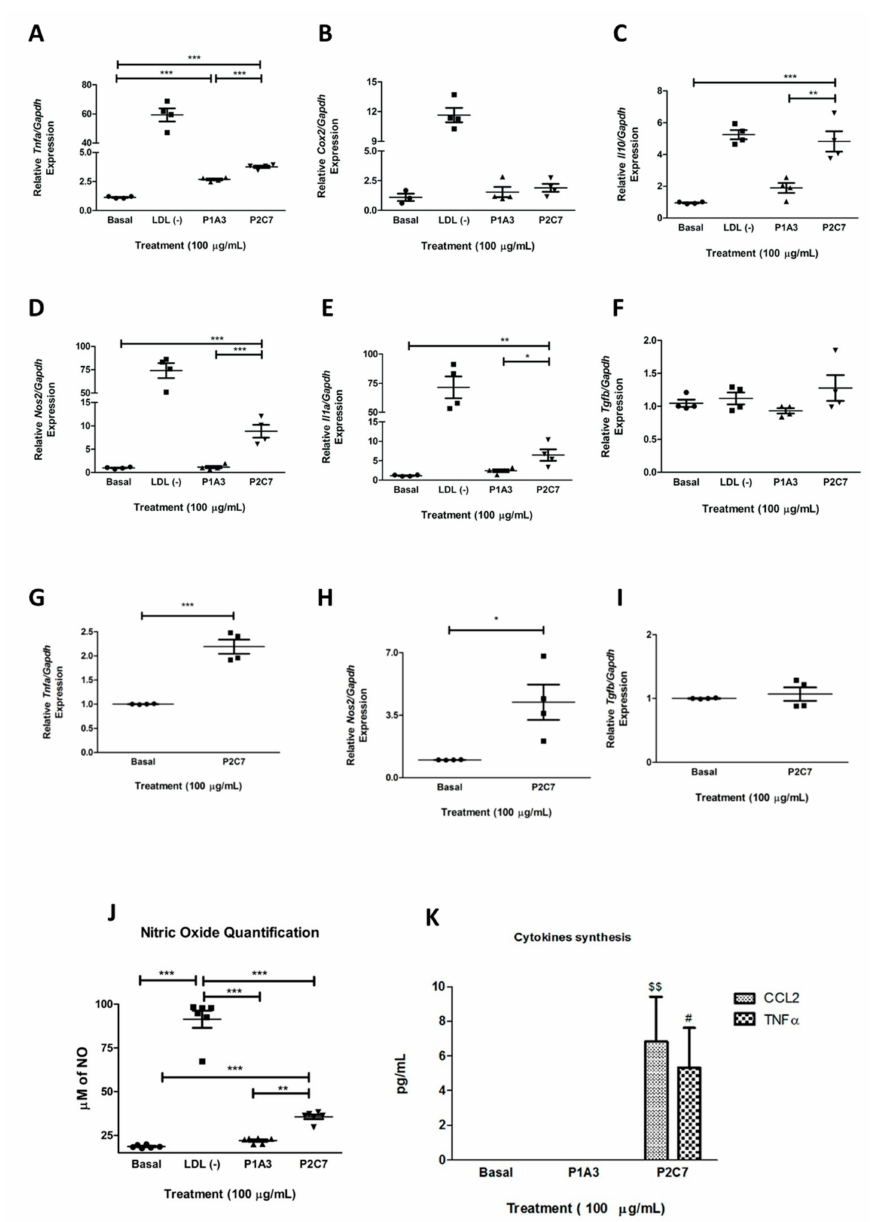
Figure 4. E ff ects of P1A3 and P2C7 treatment on macrophages. ( A – F ): Proinflammatory (TNF- α , COX-2, NOS2, and IL-1 α ; ( A , B , D , and E , respectively) and anti-inflammatory (TGF- β and IL-10; C and F, respectively) cytokine gene expression was evaluated by qPCR. The results are expressed as mean ± SD; *** p < 0.005, * p < 0.05. The comparisons P1A3 vs. P2C7 vs. basal were